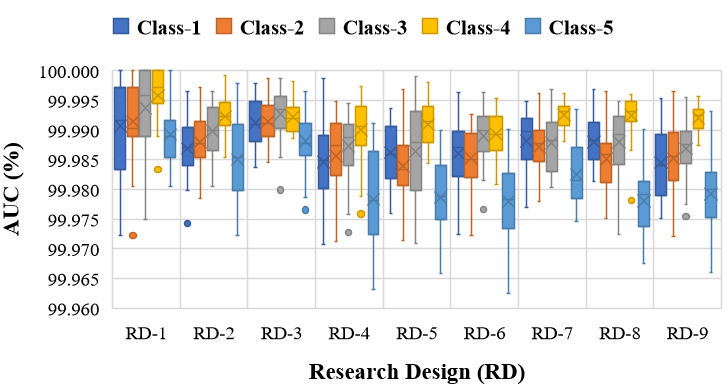
Figure 6. Area Under Curve for five classes of Toy-data for nine Research Designs (RD) of varying Test and Train data